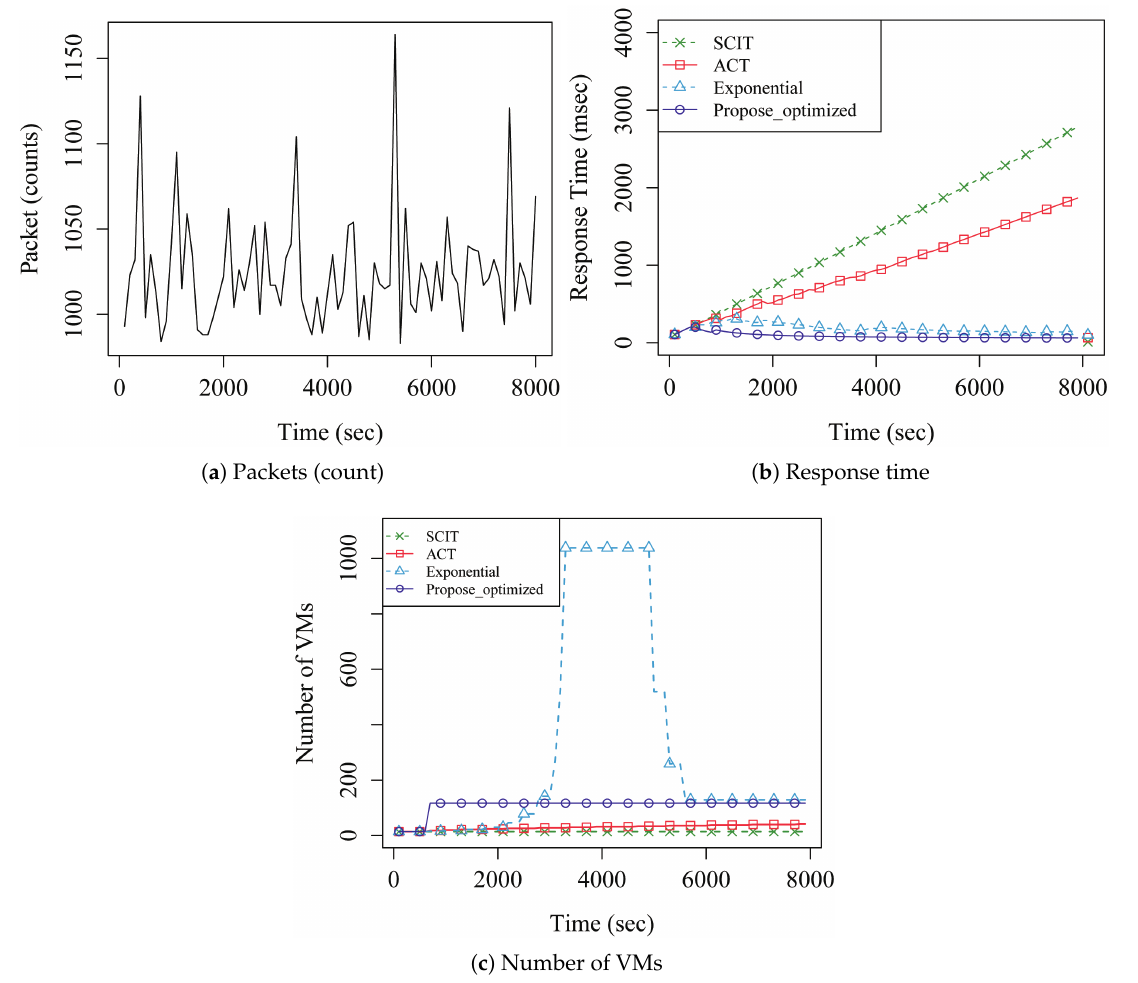
Figure 4. Scenario 2: continuous denial of service (DoS) packets. ( a ) packets (count); ( b ) response time;